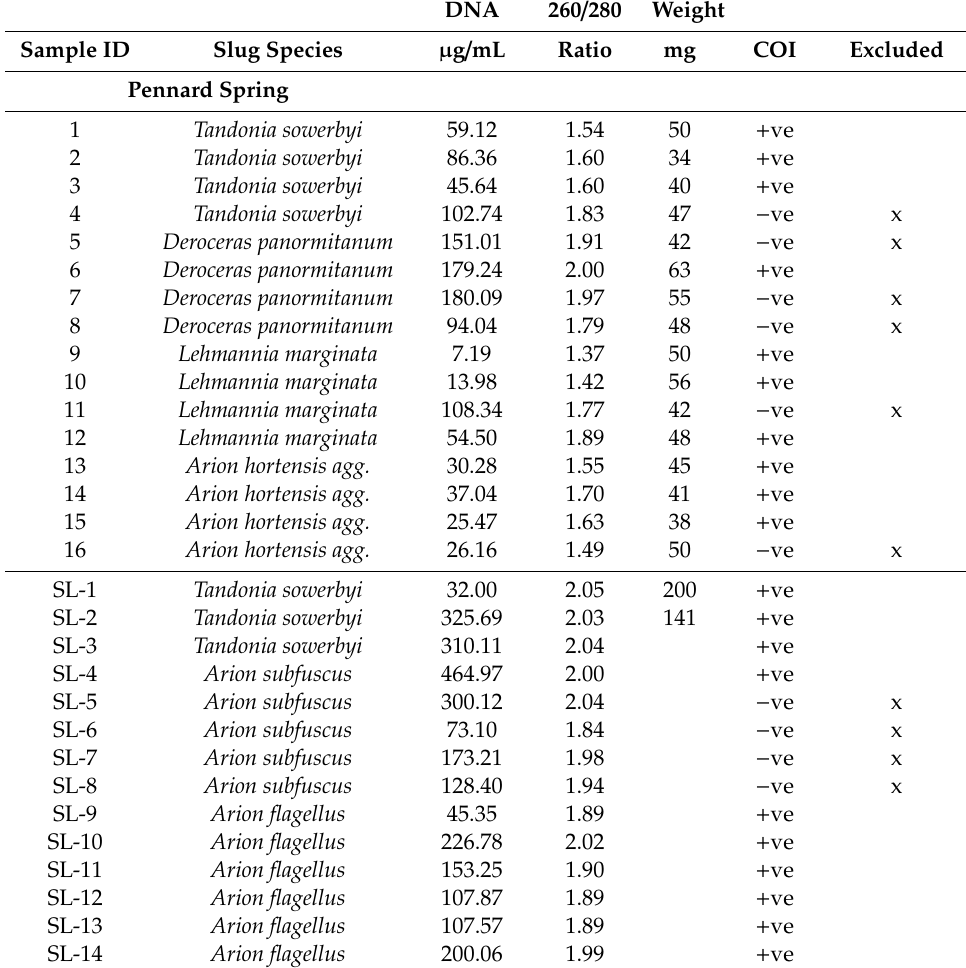
Table 2. All slug samples included in the proof of principle with their nucleic purity, tissue weight and COI result.